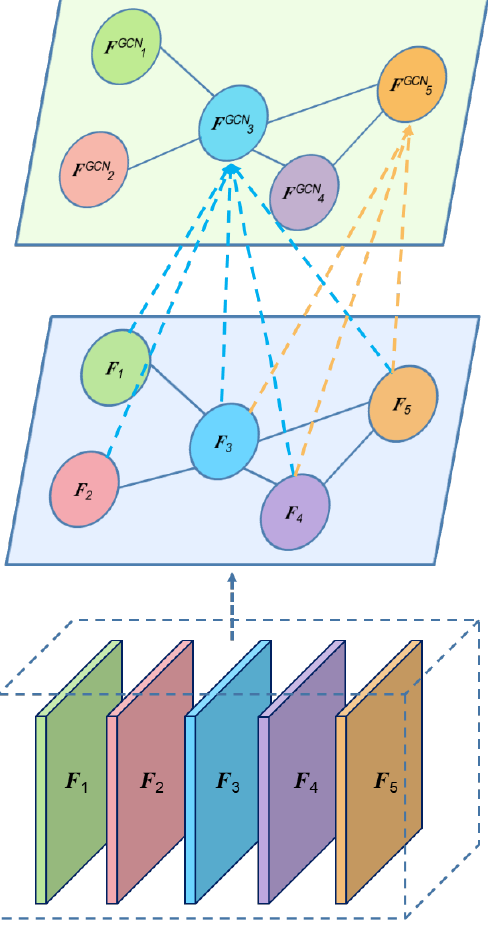
Figure 6. Graph convolution network (GCN) schematic diagram.